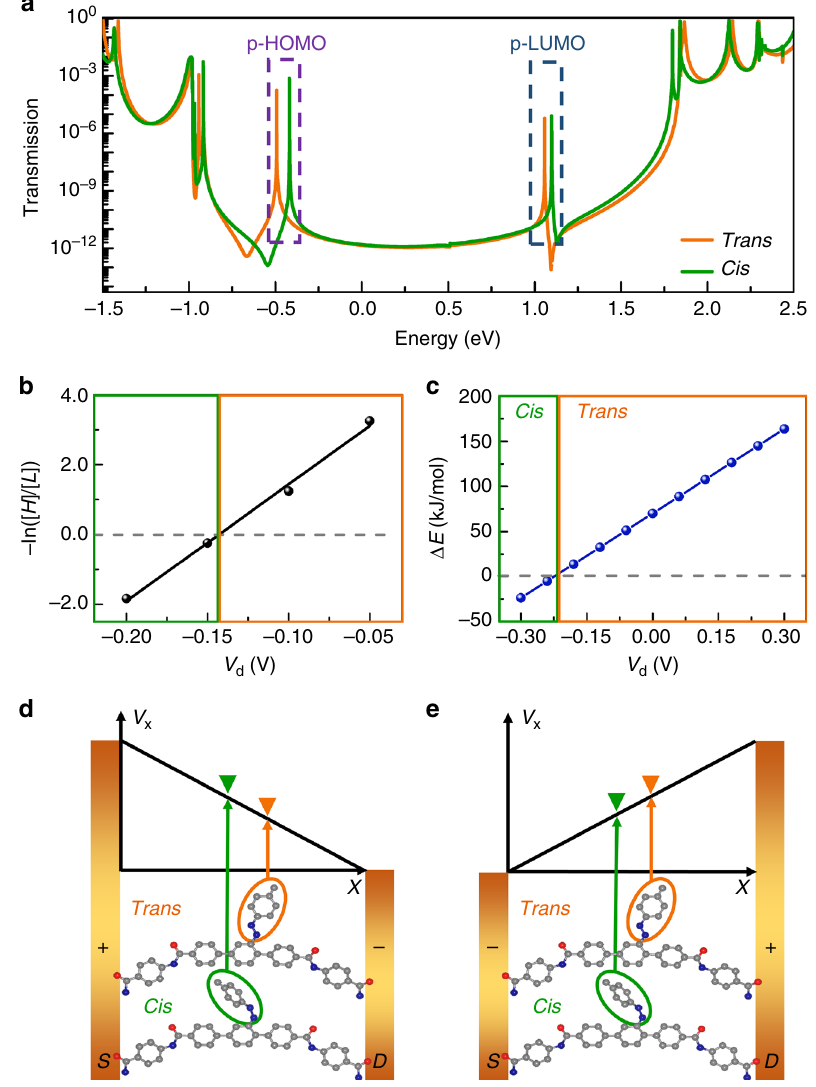
Fig. 5 Mechanism of voltage-dependent conductance switching. a Transmission spectra of a GMG-SMJ with trans (orange) and cis (green) isomers, respectively. b Voltage-dependent thermodynamic isomerisation energy parameters deduced from experimental data. c Voltage-dependent isomerisation energy diagram, which is calculated from the theoretical simulations. d , e Schematic of relative electric potential energies of trans and cis forms under positive and negative bias electric fi elds, respectively. The voltage drops of trans and cis systems were approximately treated as the same linear tendency